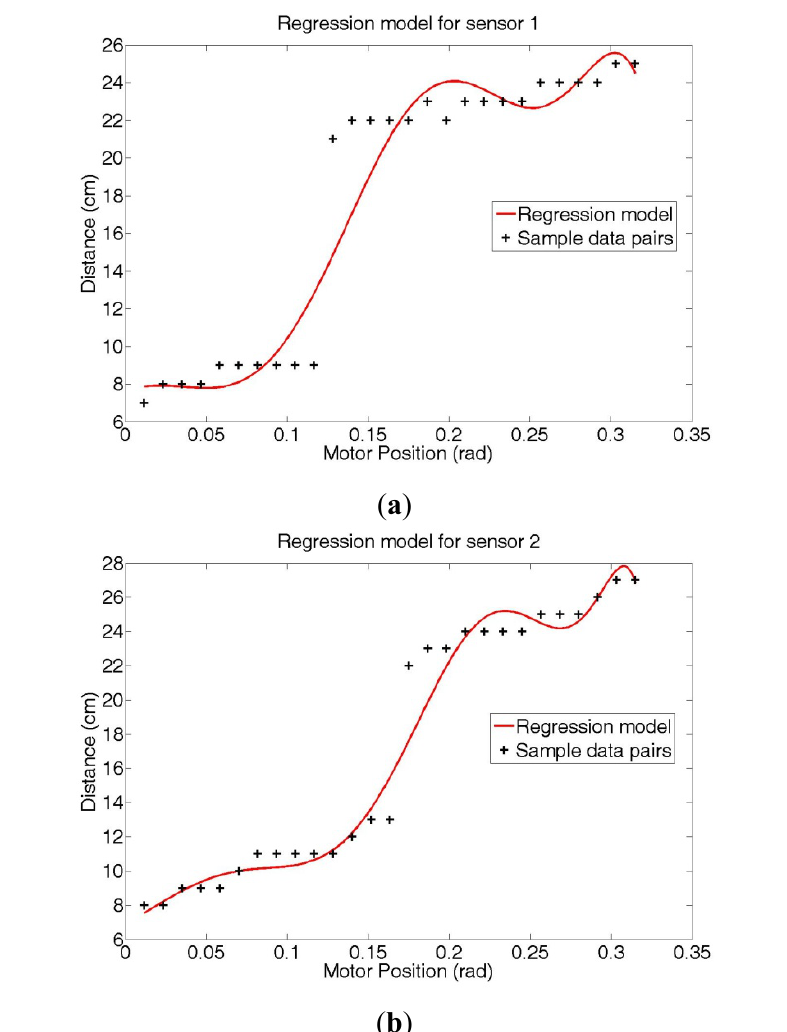
Figure 10. Function models generated by the SRI regression method for ( a ) sensor 1 ( b ) sensor 2 ( p =